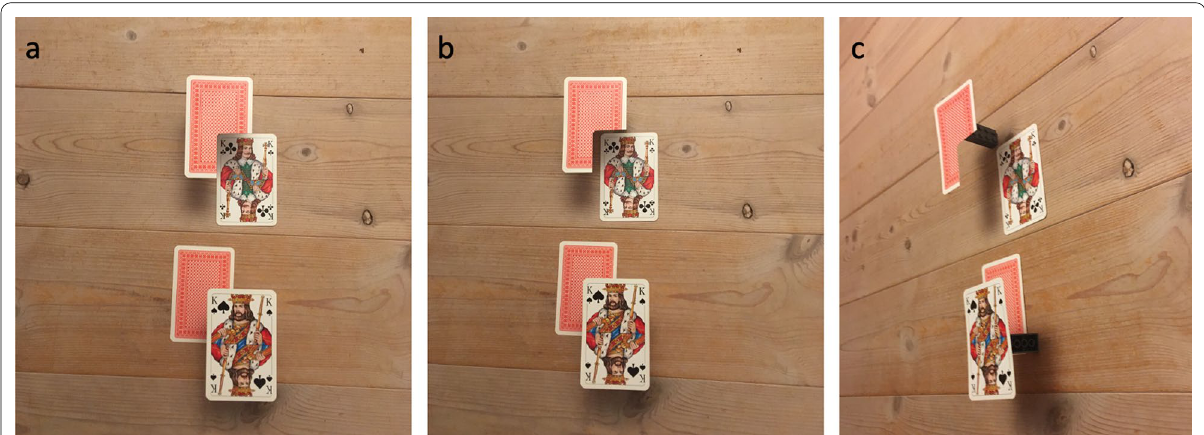
Fig. 2 An example of a visual illusion that can be explained based on the principle of generic views. The three panels show the same four cards photographed from three different viewpoints. The picture card is in the front in the bottom row, and in the back in the top row, but in panel ( a ), it appears to be in front also in the top row. Adapted from Adelbert Ames’ “overlay demonstration” (Ittelson,